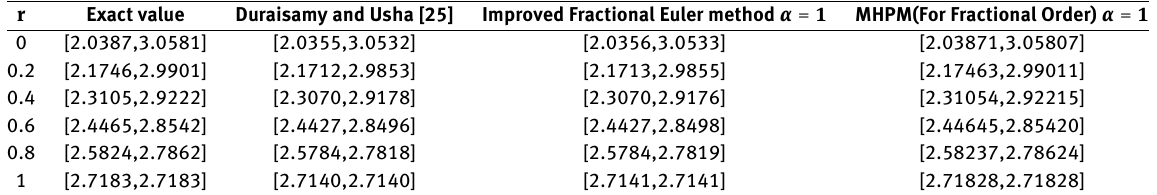
Table 1. Solutions obtained by exact method, Duraisamy and Usha [25], MHPM and IFEM for h = 0.1 at t = 1 . r Exact value